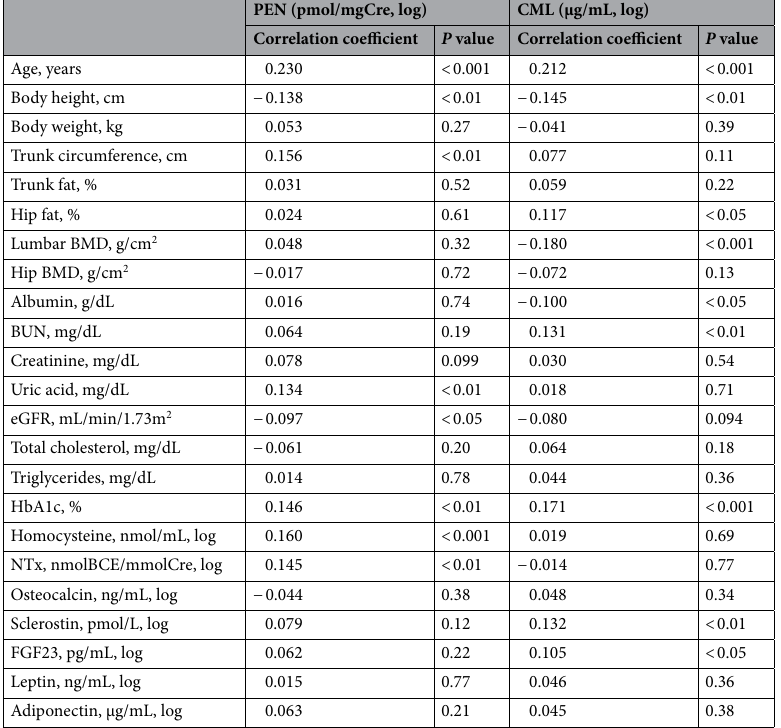
Table 2. Associations of AGEs with patient characteristics. AGEs advanced glycation end products, PEN pentosidine, CML carboxymethyl-lysine, BMD bone mineral density, BUN blood urea nitrogen, eGFR estimated glomerular filtration rate, HbA1c hemoglobin A 1c , NTx cross-linked N-telopeptide of type I collagen, FGF23 fibroblast growth factor